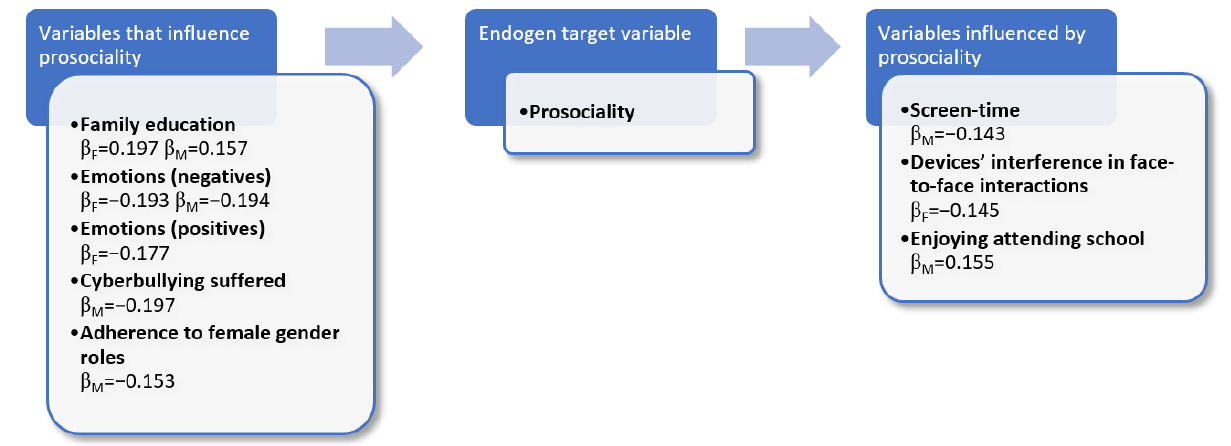
Figure 3. Results of the path models related to prosociality.